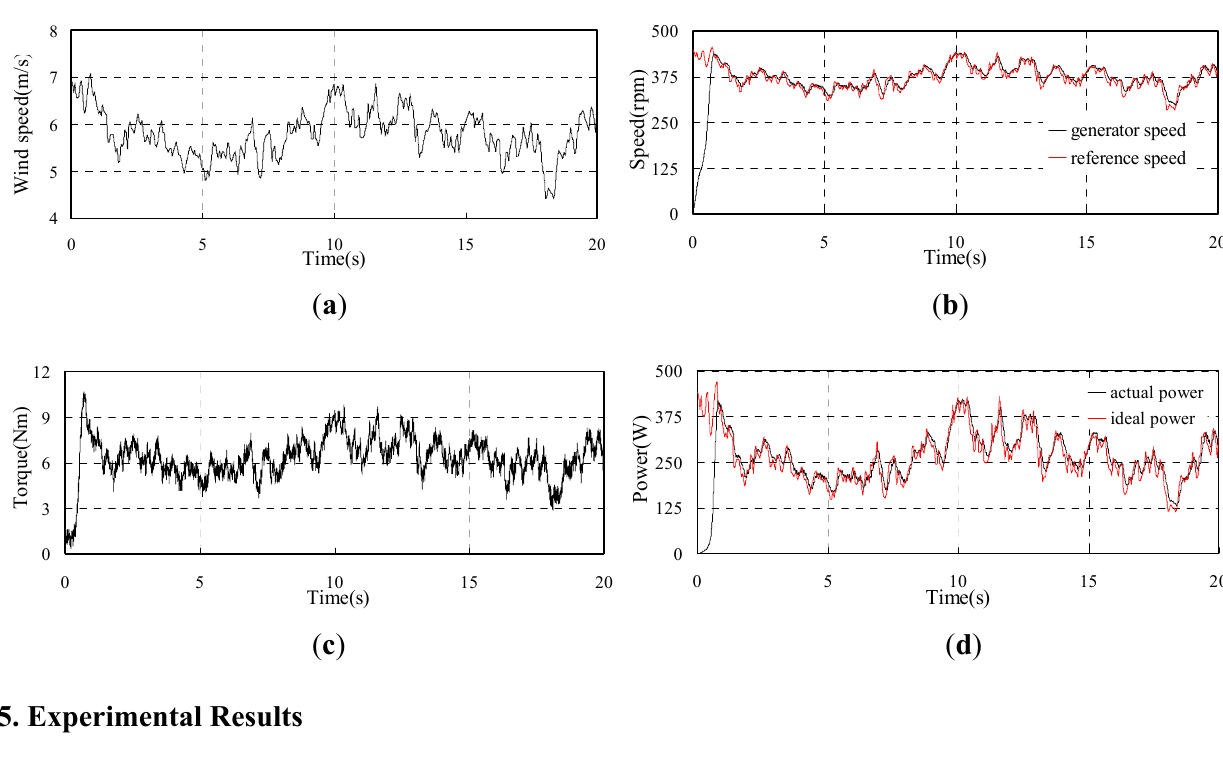
Figure 9. Simulated waveforms of PMSG with OCG MPPT ( a ) Wind speed; ( b ) Rotor speed of PMSG; ( c ) Torque of PMSG; ( d ) Output power of